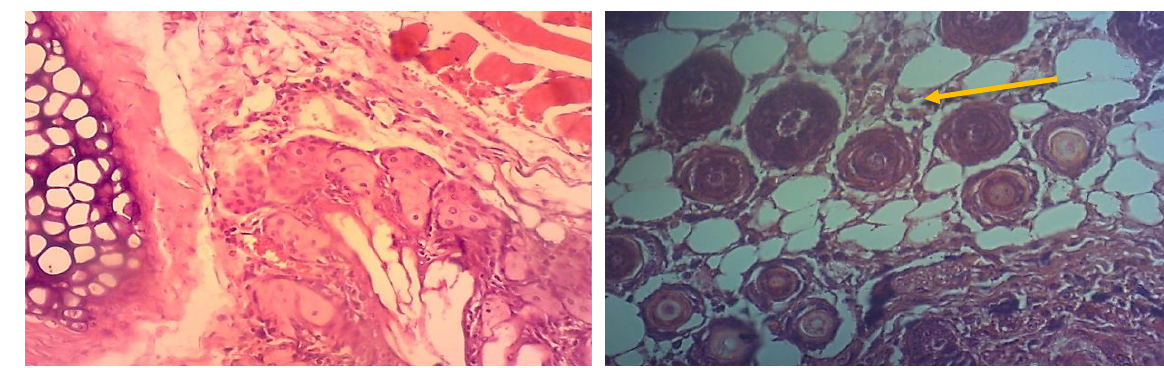
Figure, 10: Section of ear show fibrous proliferation and mononuclear cell in external canal and between fibrous connective tissue of membrane of external ear . H& E stain